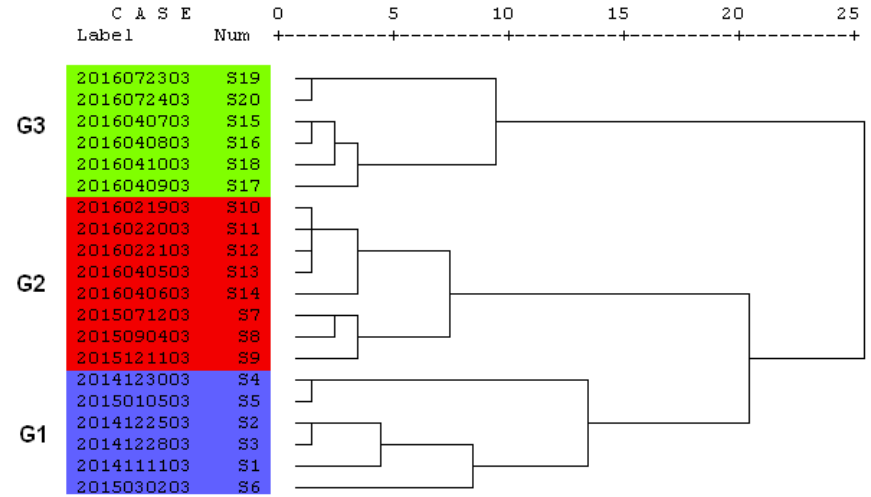
Figure 2. Dendrogram of six chemical compositions for 20 KMI samples. G1: group 1; G2: group 2; G3: group 3.